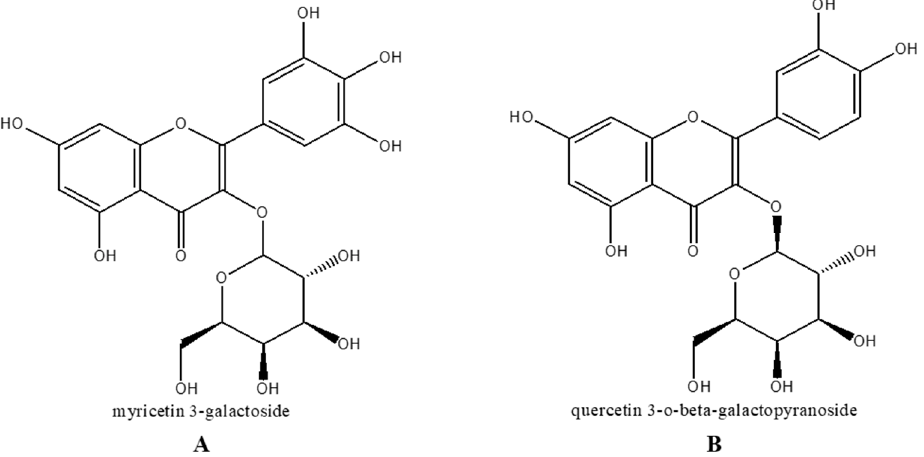
Figure 5. Isolated compounds from active n -BuOH fraction of L. tetragonum .